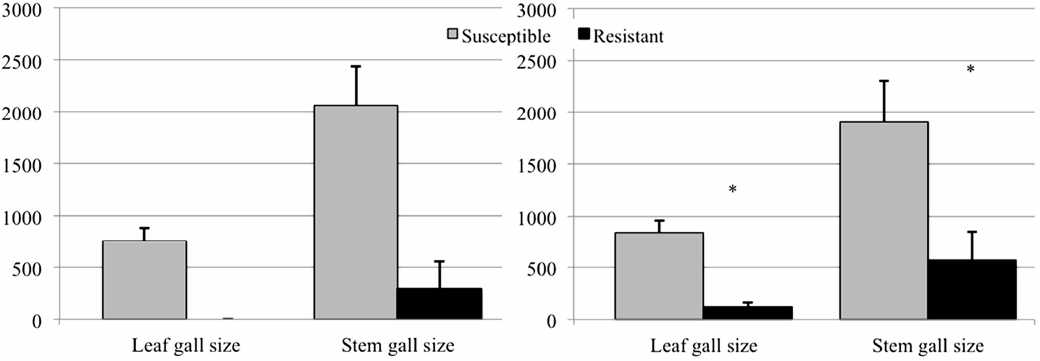
Figure 5. Mean size (in mm 3 ) of leaf and stem galls on RSE and susceptible chestnut trees in 2016 ( left ) and 2017 ( right ). Bars with * are significantly different at the 5% level, as determined by ANOVA test.